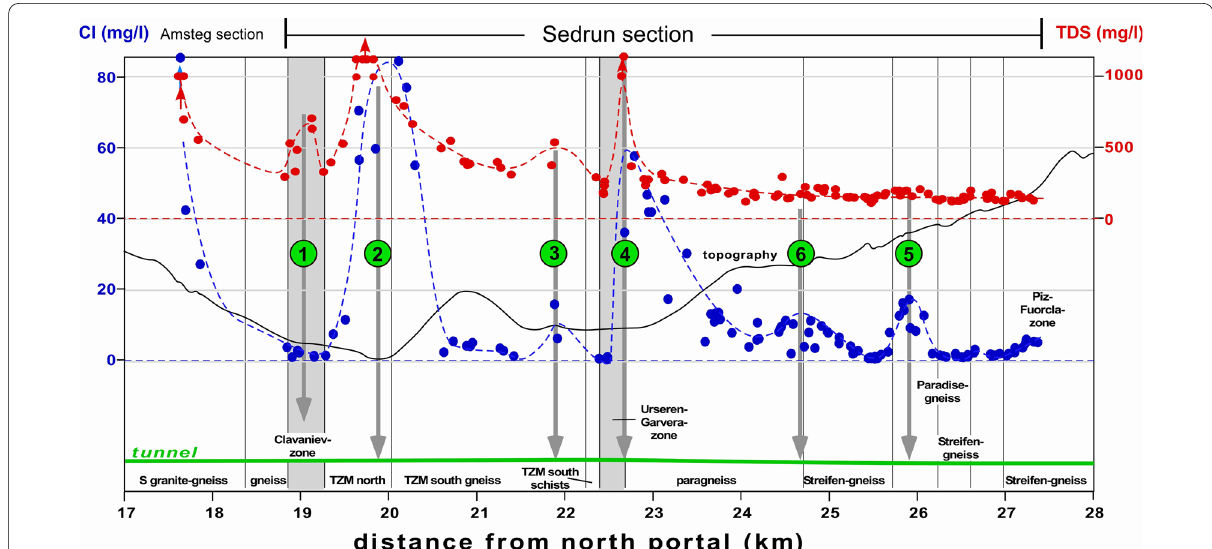
Fig. 5 Total of dissolved solids (TDS) and chloride concentration of inflows. Numbers 1–6 in green circles: strongly fractured zones with high discharge rates, high TDS and Cl (see discussion Sect.